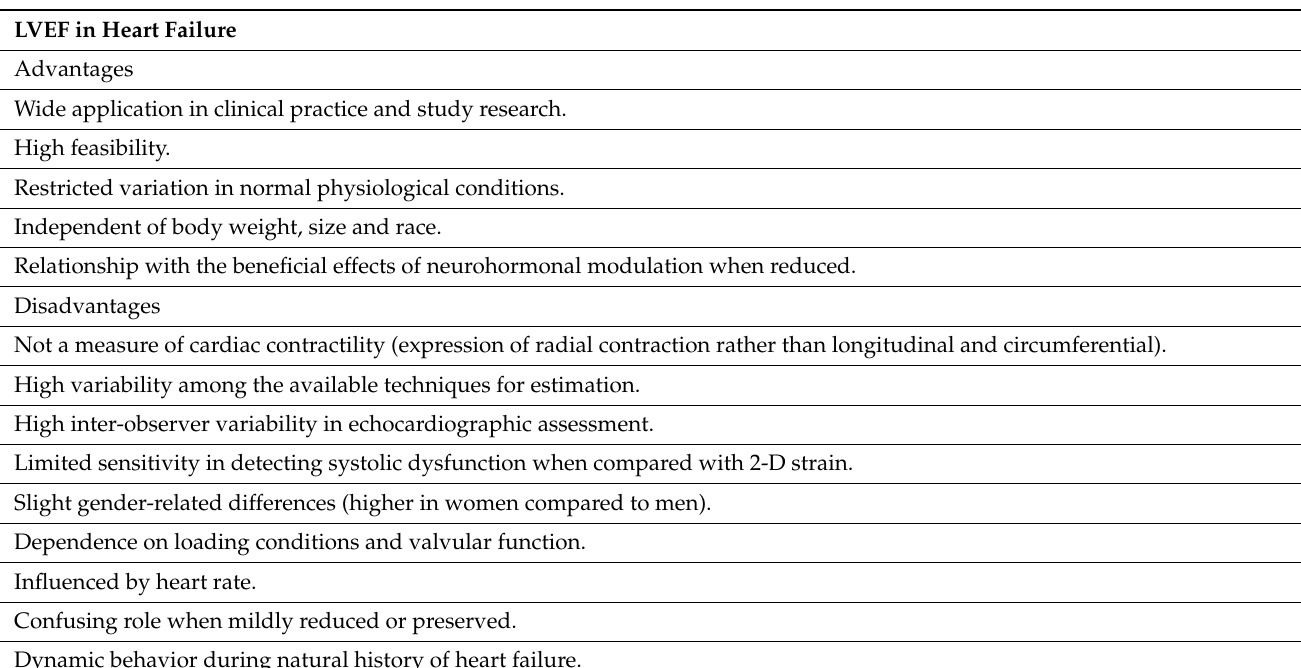
Table 2. Advantages and limitations of using LVEF: high feasibility and wide application are balanced by poor relationship to effective hemodynamic status and high